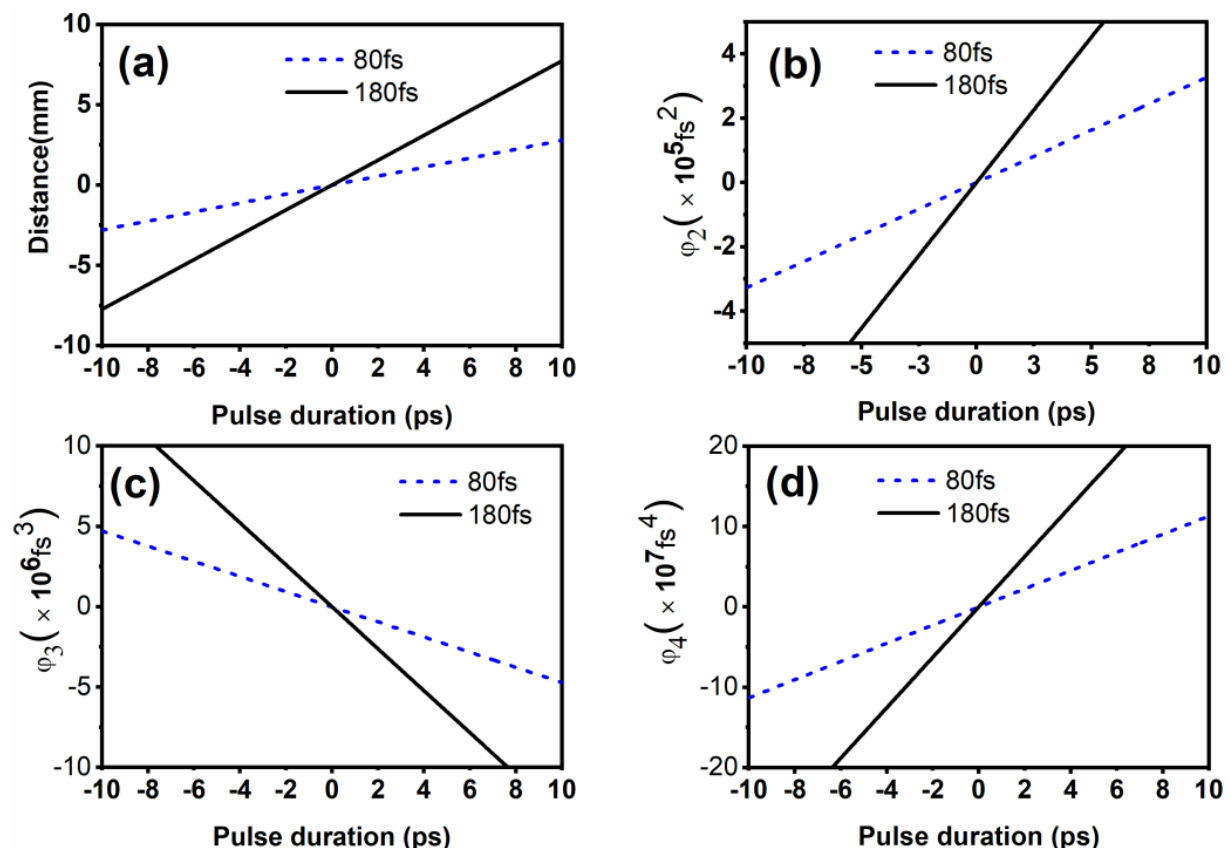
Figure 4. Distance of adjustment compressor gratings, the GVD, TOD, and FOD change with pulse durations by the adjustable compressor for the pulse durations of 180 fs (solid black lines) and 80 fs (dotted blue lines), respectively. ( a ) Distance; ( b ) GVD; ( c ) TOD; ( d ) FOD.